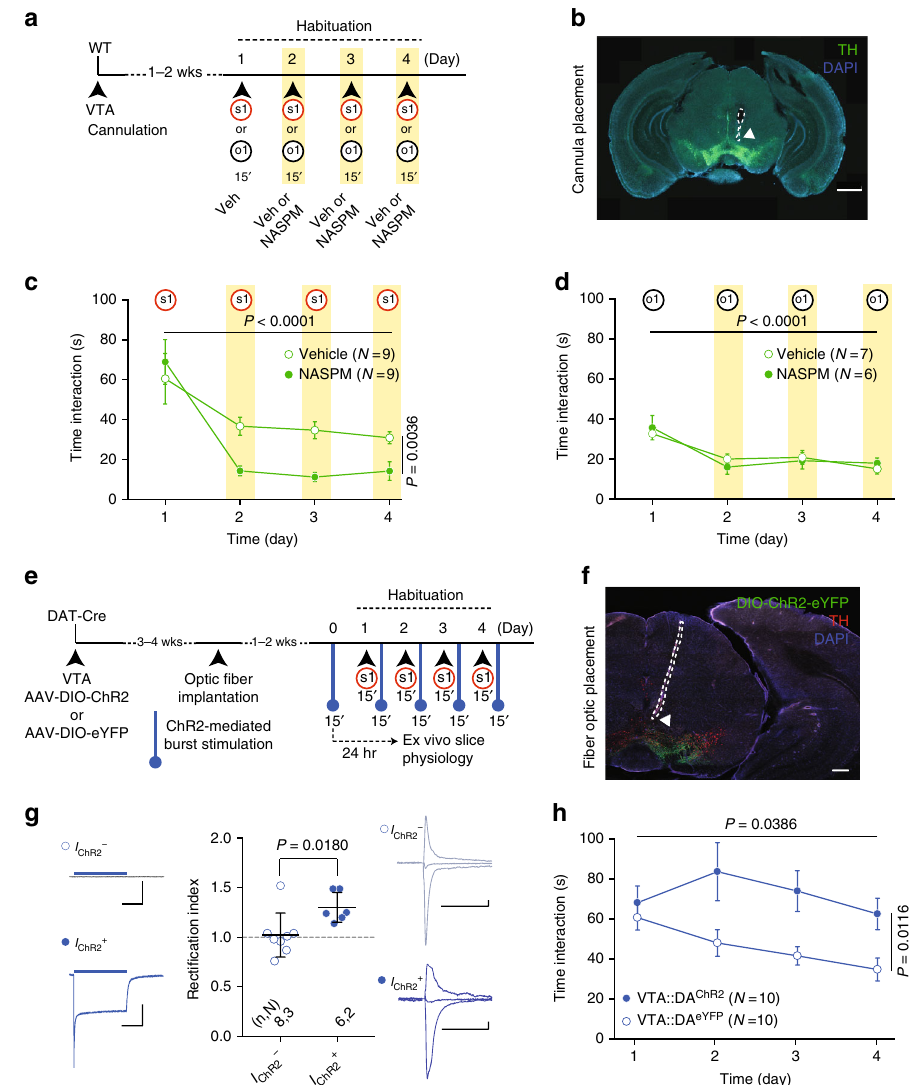
Fig. 7 GluA2-lacking AMPAR function controls habituation to nonfamiliar conspeci fi c. a Schema of the experimental paradigm. b Representative image of cannula placement for NASPM or vehicle infusion (green: TH; blue: DAPI; white arrow indicates cannula tip). c Time course of time interaction with a nonfamiliar conspeci fi c (s1) for vehicle or NASPM infused mice at day 2, day 3, and day 4. RM two-way ANOVA (time main effect: F (3, 24) = 17.57, P < 0.0001; drug main effect: F (1, 8) = 16.48, P = 0.0036; time × drug interaction: F (3, 24) = 3.141, P = 0.0439). d Time course of time interaction with a novel object (o1) over 4 days for Vehicle and NASPM groups. RM two-way ANOVA (time main effect: F (3, 33) = 24.71, P < 0.0001; drug main effect: F (1,11) = 0.00005, P = 0.9942; time × drug interaction: F (3, 33) = 1.109, P = 0.3595). e Experimental paradigm for noncontingent optogenetic stimulation. f Representative image of optic fi ber placement for DIO-ChR2 expressing mice (red: TH, green: AAV-DIO-ChR2-eYFP, blue: DAPI; white arrow indicates + ) VTA DA neuron. Scale bars: 20 msec, 1 nA. fi ber optic tip). g Left: example traces of a photocurrent negative (I − ) and a photocurrent positive (I ChR2 ChR2 Middle: scatter plot of RI recorded from photocurrent negative (I ChR − ) and photocurrent positive (I ChR2 + ) VTA DA neurons and AMPAR-EPSCs example traces ( − 60, 0, and 40 mV) recorded from VTA DA neurons. Mann − Whitney test ( U = 6). Scale bars: 20 msec, 20 pA. h Time course over 4 days of time interaction with a nonfamiliar conspeci fi c (s1) for VTA::DA ChR2 and VTA::DA eYFP mice with noncontingent optical stimulation. RM two-way ANOVA (time main effect: F (3, 18) = 2.9966, P = 0.0386; virus main effect: F (1, 18) = 7.9034, P = 0.0116; time × virus interaction: F (3, 18) = 1.9532, P = 0.1320). N indicates number of mice. Error bars represent